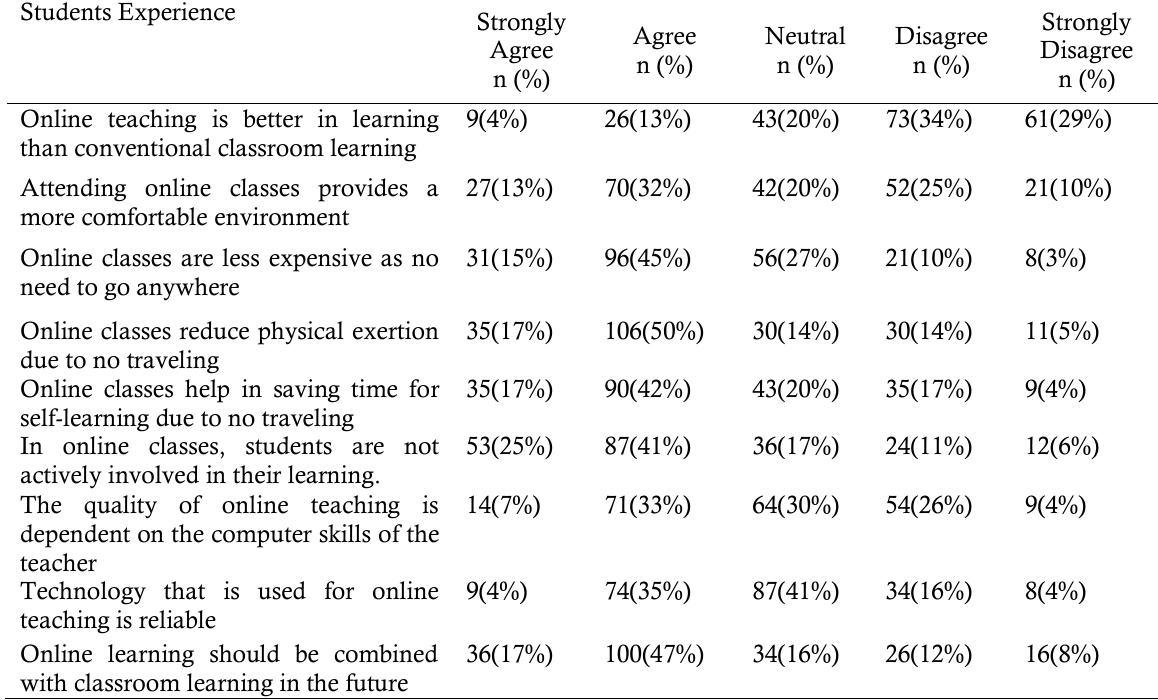
Table 5 <Attitude of medical students towards online teaching